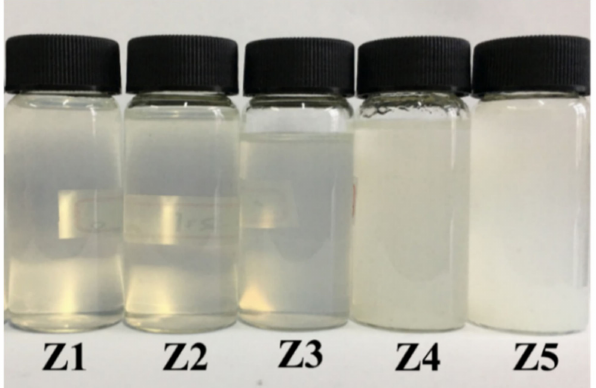
Figure 2. SiO 2 / ZrO 2 composite-hardening sol with di ff erent proportion.